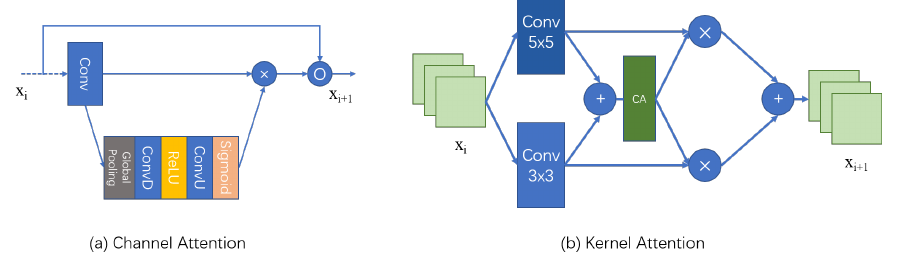
Figure 3. Channel attention and kernel attention, ‘O’ denotes add or concatenate